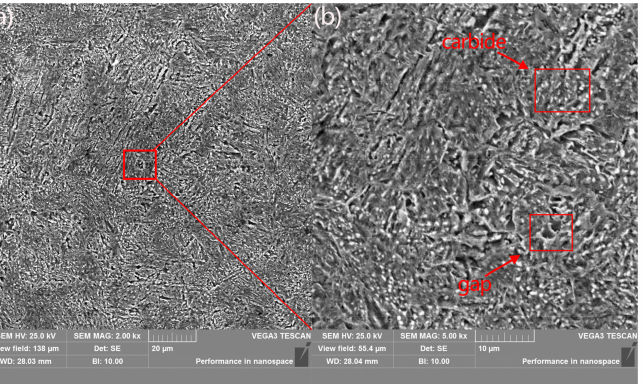
Figure 2. Microstructure of annealed and air-cooled 42CrMo alloy steel ( a ) SEM, magnification × 5000. ( b ) SEM, magnification ×